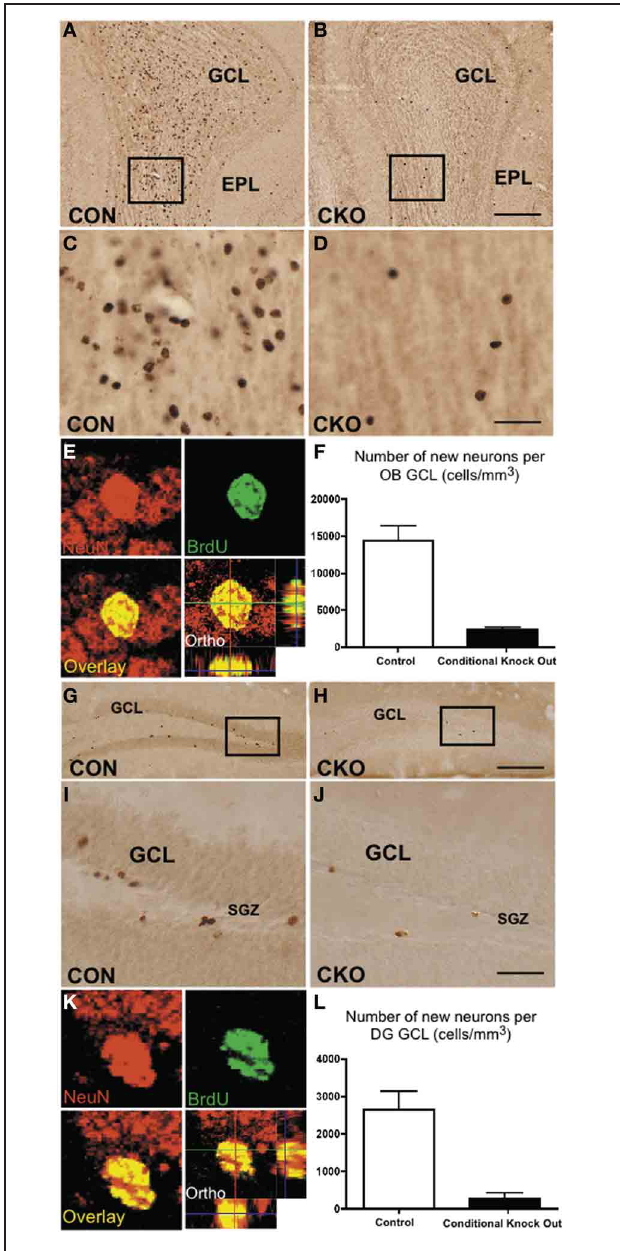
FIGURE 2 | Depleted ability to generate new granule neurons in OB and DG of adult DNMT1-cKO mice. (A–D) Fourteen days after i.p. injection, BrdU labels many newly generated cells in granule cell layer (GCL) of OB in control (A,C) but few in DNMT1-cKO (B,D) adult mice. EPL, external plexiform layer (E) Confocal optical slice through an adult born neuron in GCL of OB stained green for the neuronal maker, NeuN and red for BrdU. (F) Stereological analysis showed a pronounced and statistically significant 85% reduction in the generation of new neurons in adult OB GCL of DNMT1-cKO mice relative to controls, p < 0 . 001, t -test, both groups n = 6. (G–J) BrdU labels many newly generated cells 14 days after i.p. injection in GCL of DG in control (G,I) but few in DNMT1-cKO (H,J) adult mice. (K) As in E but for neuron in GCL of DG. (L) Stereological analysis showed a pronounced and significant 90% reduction in the generation of new neurons in adult DG GCL of DNMT1-cKO mice relative to controls, p < 0 . 001, t -test, both groups n =